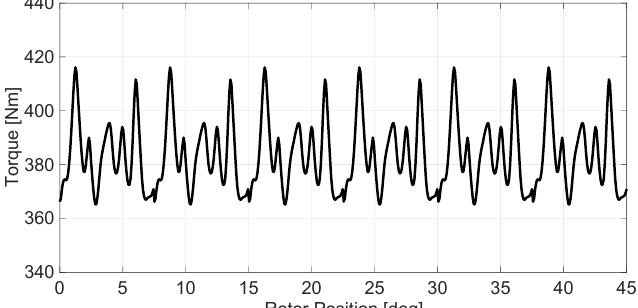
Figure 9. Analysis of the SynREL motor.